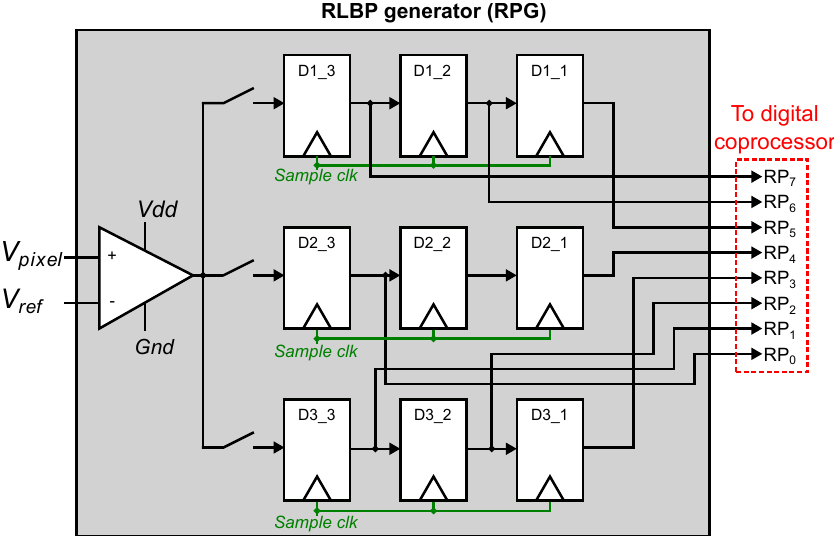
Figure 9. Architecture of the RPG. An input comparator compares the local gradient value for each pixel to a reference voltage. The digital comparator outputs are sequentially stored in an array of 3 × 3 flip-flops, organized as three shift registers. The RPG outputs an 8-bit RLBP with the output of all the flip-flops except for the one at the